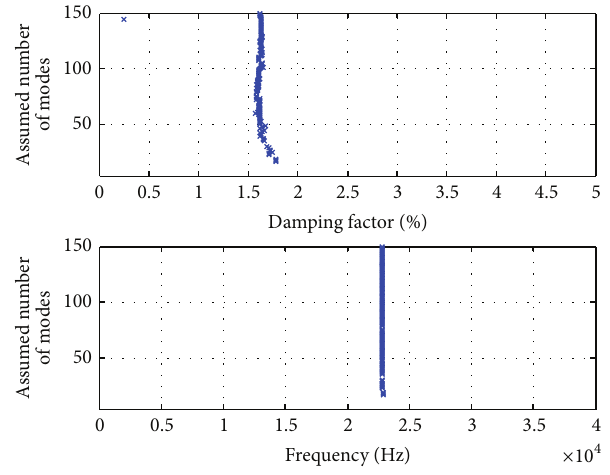
Figure 10: Stabilization diagram on resonance frequency and damping factor for the experimental perforated microplate using shifting properties of the block observability matrix.